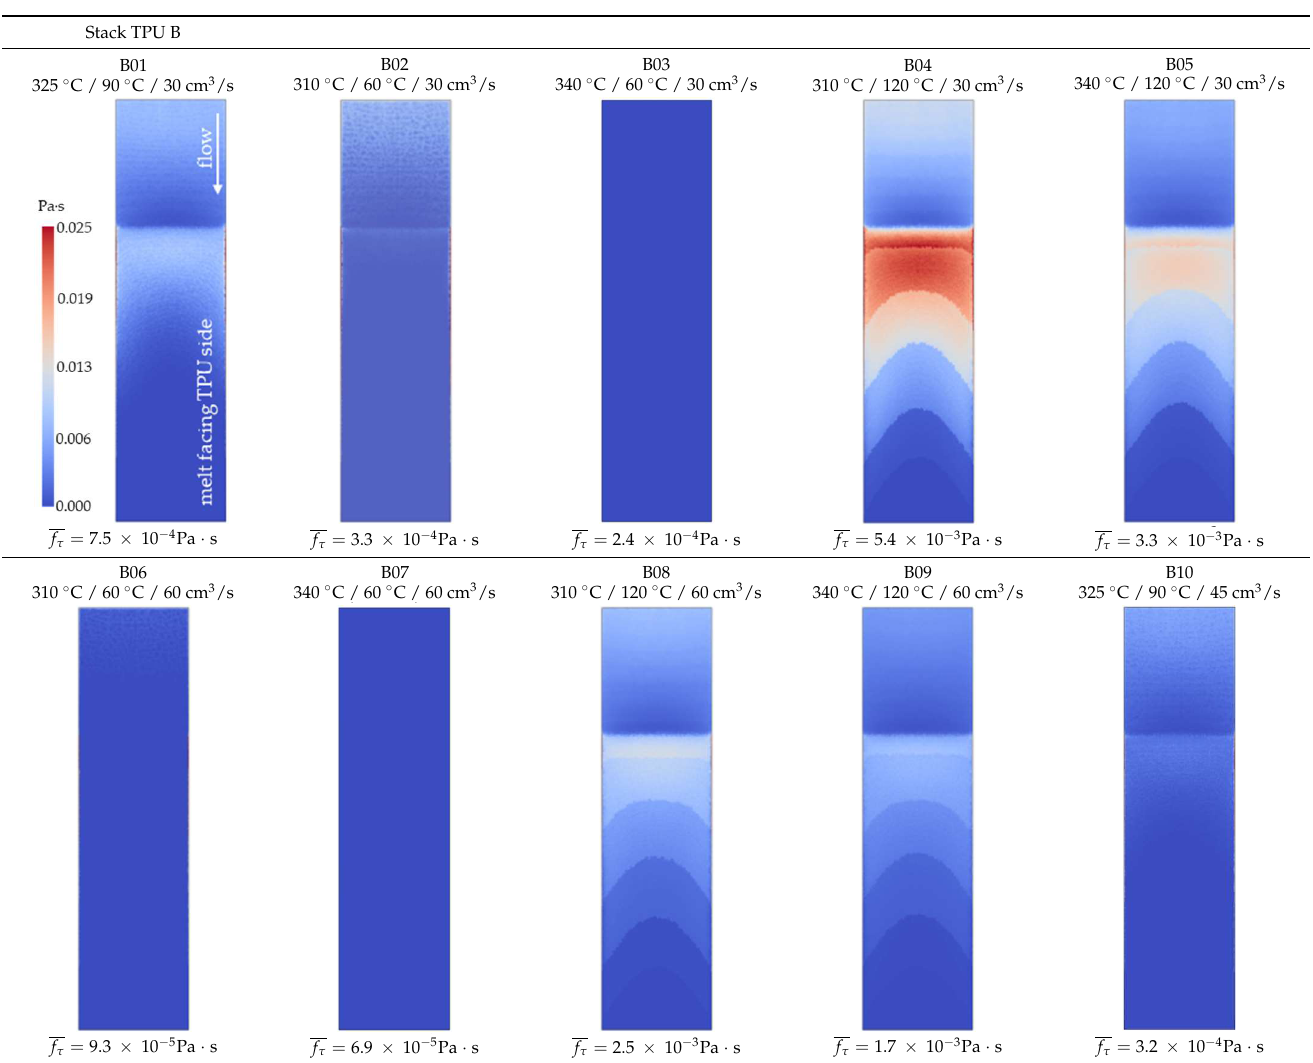
Table 5. Shaded contour plots of the calculated shear distortion factor for film strips using TPU B for molding settings as outlined in Table 1.